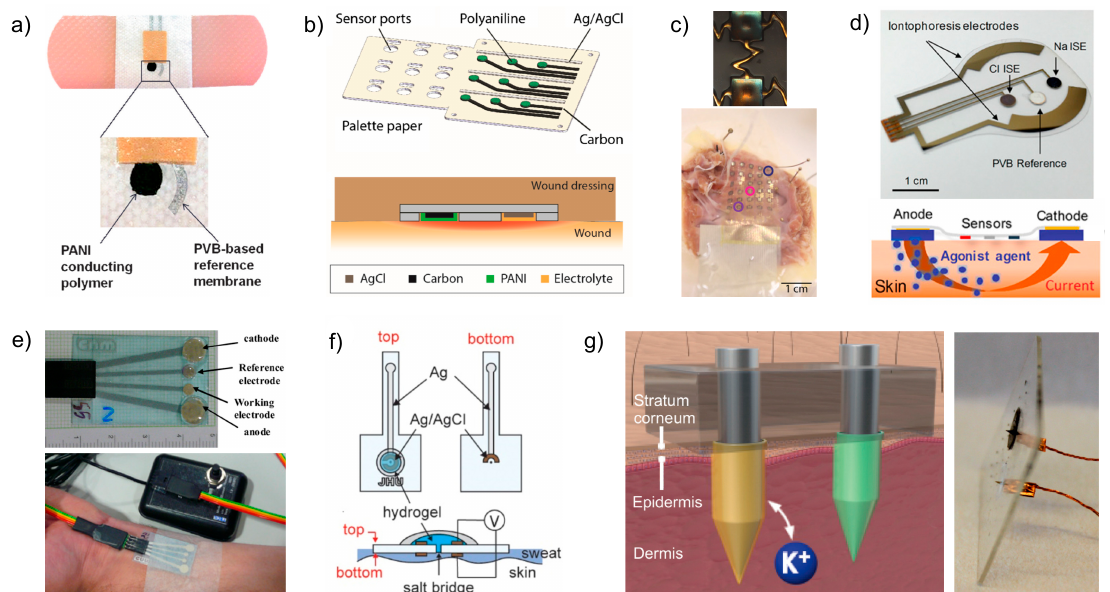
Figure 3. ( a ) Image displaying the potentiometric sensor printed on a band aid developed by Guinovart et al. Reproduced from [51] with permission from John Wiley & Sons, Inc. ( b ) Three-dimensional scheme of the pH sensor array by Rahimi et al. with a magnification of the cross-section of the area in which the sensors are embedded into a wound dressing. Reprinted from [52], with permission from Elsevier, Copyright 2018. ( c ) Wearable pH sensor reported by Chung et al. Top: Picture of one gold electrode after IrOx electroplating. Bottom: Human right ventricular wedge preparation with endocardial surface in contact with the wearable pH sensor array. Reproduced from [54], with permission from John Wiley & Sons, Inc. ( d ) Scheme of the wearable device by Emaminejad et al. based on iontophoresis for sweat extraction [57]. ( e ) Wearable sensor for Cl − detection reported by Gonzalo-Ruiz et al. based on iontophoresis-induced sweat collection [58]. Reprinted from [58], with permission from Elsevier, Copyright 2018. ( f ) Schematic illustration of the sweat Cl − sensor based on a salt bridge [59,60]. Reprinted from [59], with permission from Elsevier, Copyright 2018. ( g ) Illustration and picture of the microneedle-based patch for transdermal K + detection in interstitial fluid. Reprinted from [61] with permission from the American Chemical Society, Copyright 2019.